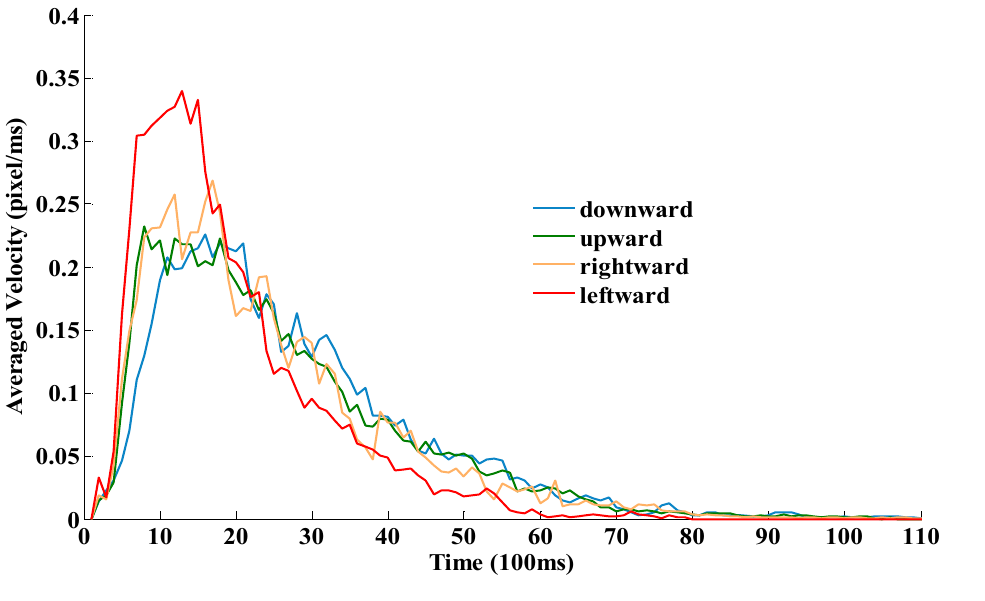
Figure 3. The interaction between velocity (pixel/ms) in each cursor moving